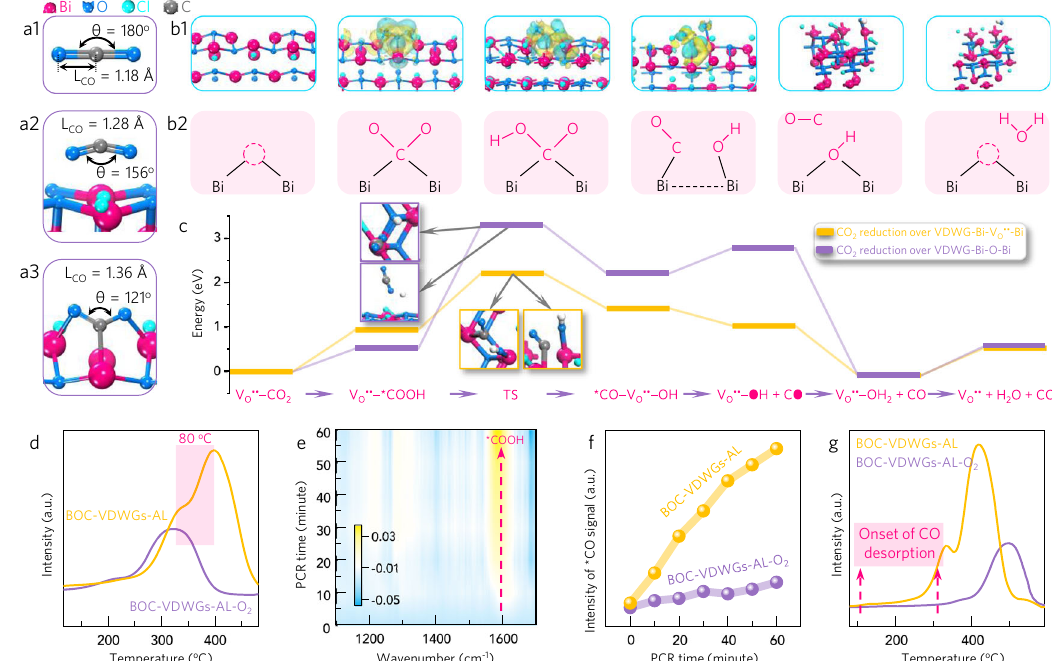
Fig. 4 Promoting effect of VDWGs-associated defect on CO 2 -to-CO catalysis. a C – O bond length and O – C – O bond angle of free CO 2 ( a1 ), CO 2 adsorbed on VDWG-Bi-O-Bi ( a2 ), and CO 2 adsorbed on VDWG-Bi-V O (cid:129)(cid:129) -Bi ( a3 ). b1 Optimized geometric structures (parts containing charge density differences) and b2 schematic illustration of intermediates generated during CO 2 -to-CO catalysis over VDWG-Bi-V O (cid:129)(cid:129) -Bi. c Gibbs free energy diagrams of intermediates generated during CO 2 -to-CO catalysis over VDWG-Bi-O-Bi and VDWG-Bi-V O (cid:129)(cid:129) -Bi. d CO 2 -TPD of BOC-VDWGs-AL and BOC-VDWGs-AL- O 2 . e In situ FTIR of intermediates generated during pure-water PCR over BOC-VDWGs-AL. f Comparison of FTIR signal intensity of *CO intermediates from BOC-VDWGs-AL and BOC-VDWGs-AL-O 2 -driven pure-water PCR. g CO-TPD of BOC-VDWGs-AL and BOC-VDWGs-AL-O 2 . The